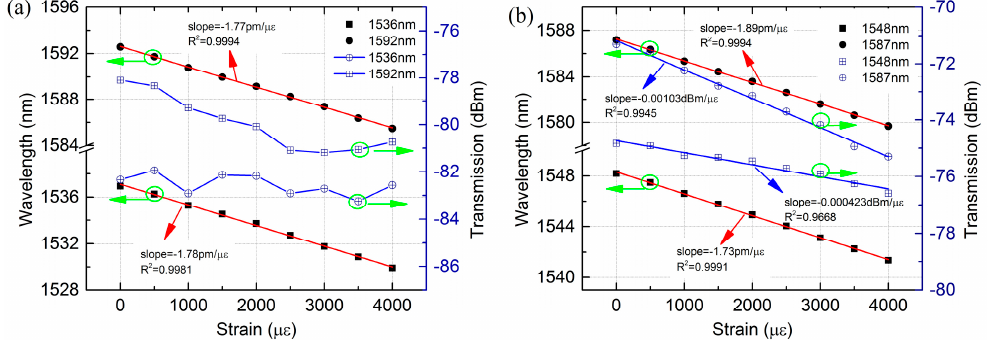
Figure 7. Wavelength shifts and transmission loss of different dips as a function of strain: ( a ) the MZI with 35 mm PCF; ( b ) the MZI with 40 mm PCF.